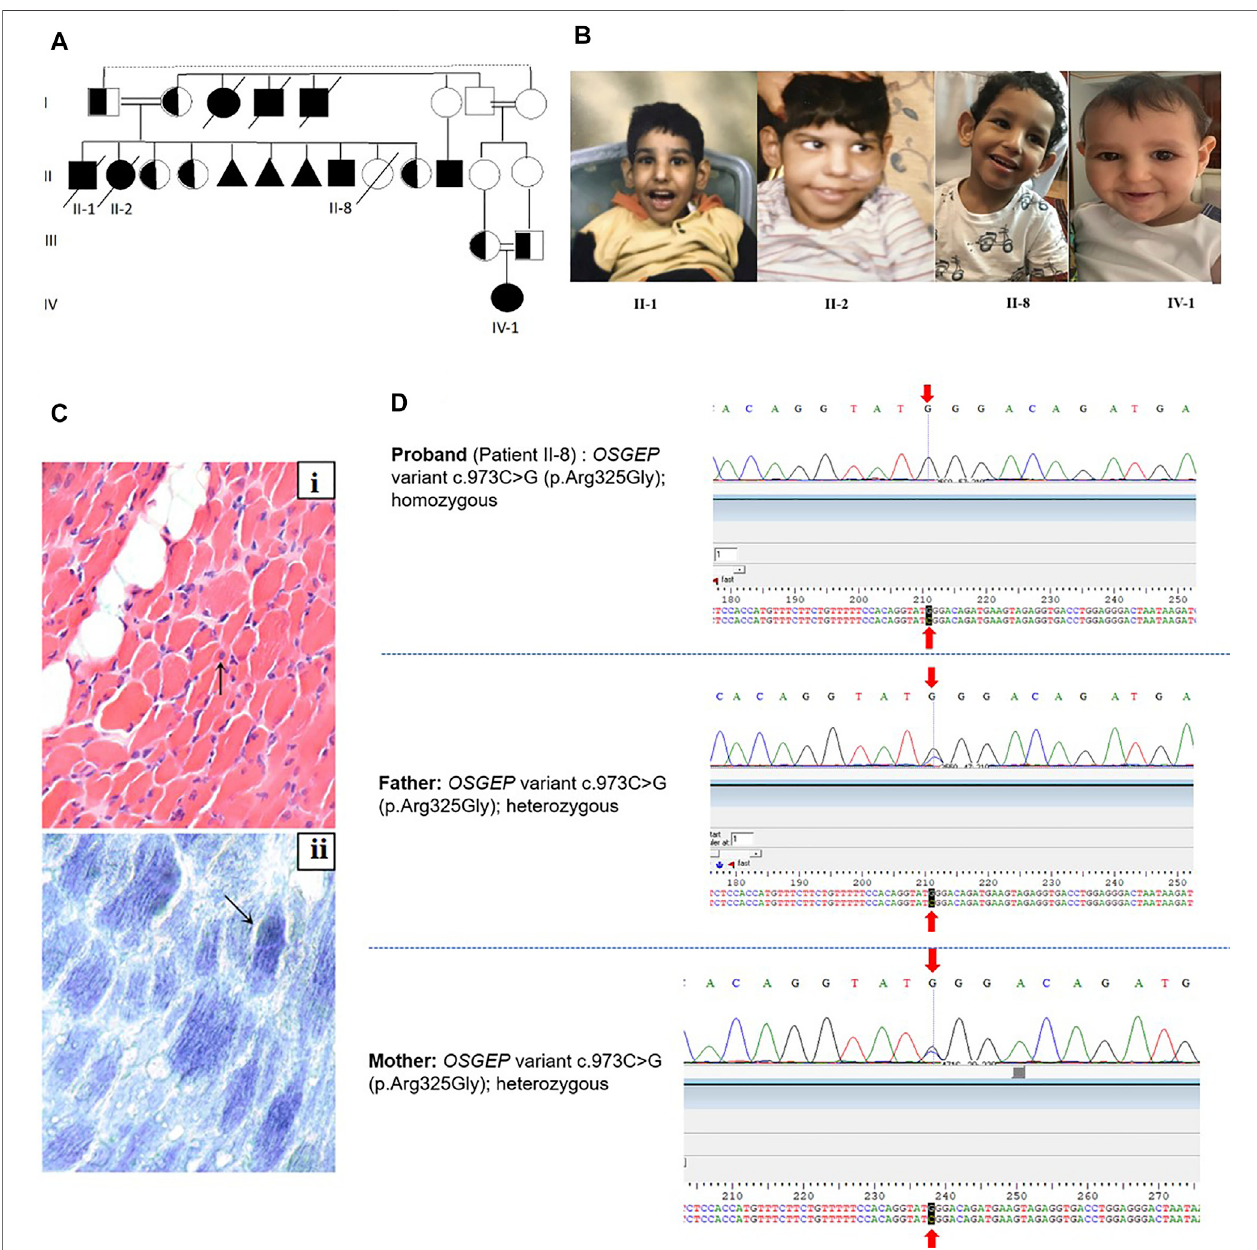
FIGURE 1 | (A) Family pedigree. II-8 is the index patient. (B) Facial dysmorphic features of the three affected siblings. The facial dysmorphism includes microcephaly, almond-shaped eye, abnormally high but narrow forehead, ocular hypertelorism, depressed nasal bridge, and large and low-set ears. (C) Muscle biopsy of II-2: (i) Muscle biopsy shows a marked variation in fi ber size with multiple scattered markedly atrophic fi bers (arrow). Mild increased endomysial fi brosis and focal fat deposition are noted in the background (H&E, x400). (ii) Oxidative enzymes show mildly increased staining in scattered fi bers (arrow, NADH, x400). (D) Sanger sequencing of the proband (II-8) and